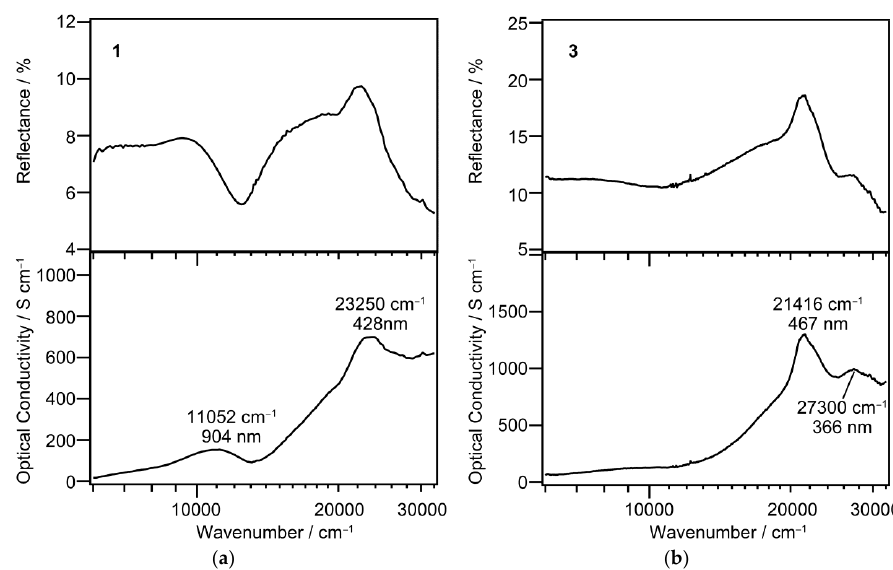
Figure 5. Single-crystal reflectance (upper) and optical conductivity (lower) spectra at room temperature for 1 ( a ) and 3 ( b ).